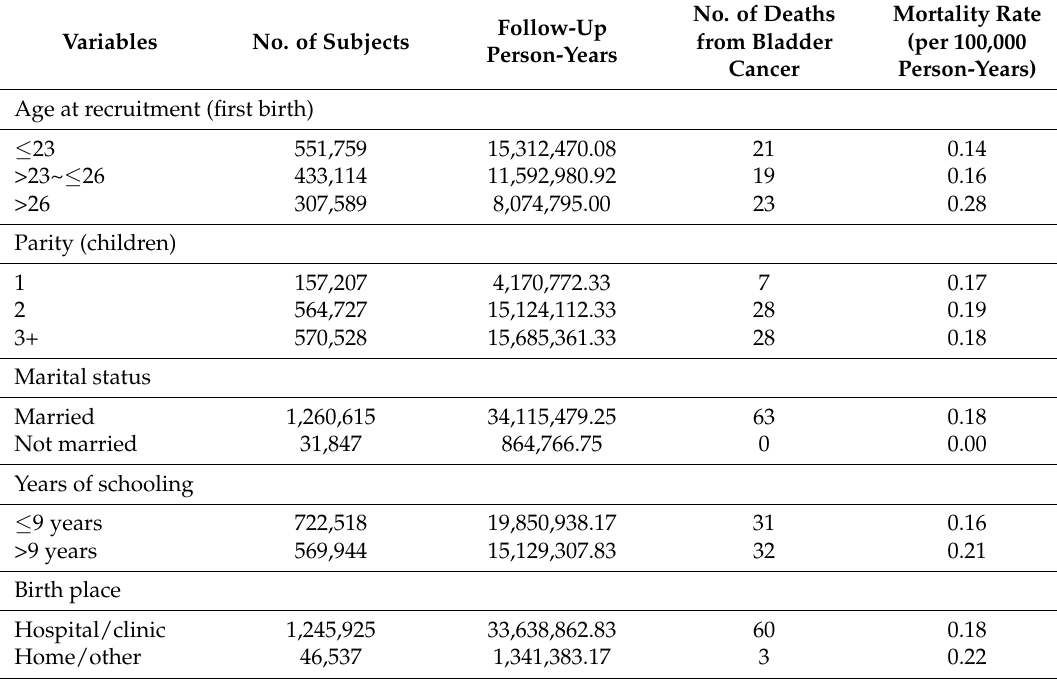
Table 1. Demographic characteristics of the study